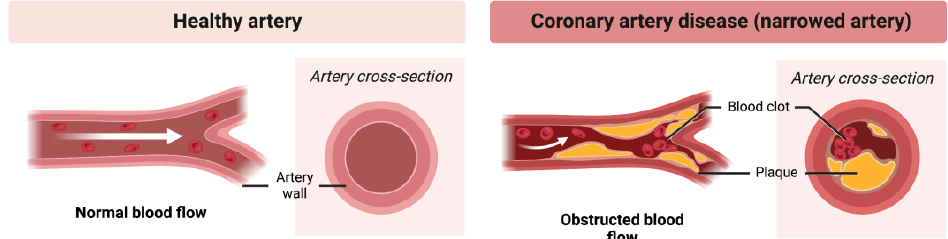
Figure 3. Atherosclerosis. Narrowing of the artery and obstructed blood flow.